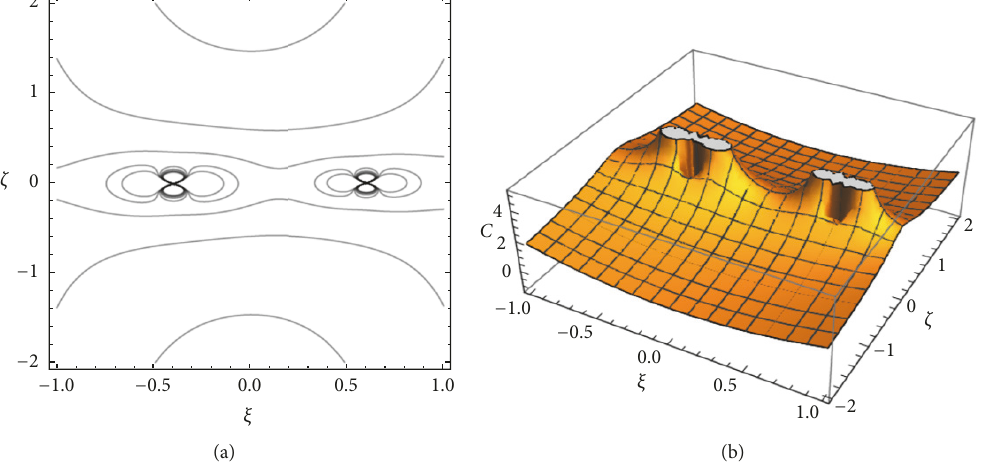
Figure 3: Zero-velocity curves in the ( 𝜉 − 𝜁 ) plane of PSR 1903+0327 for 𝐴 = 0.02, 𝑎 = 0.95, 𝜎 1 = 0.01 and 𝜎 2 = 0.005 .